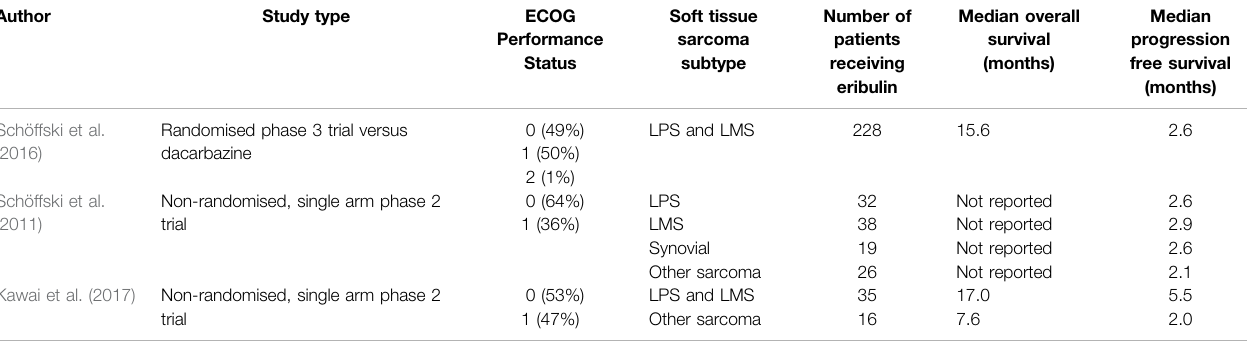
TABLE 1 | Phase 2 and 3 clinical trials for eribulin in STS.